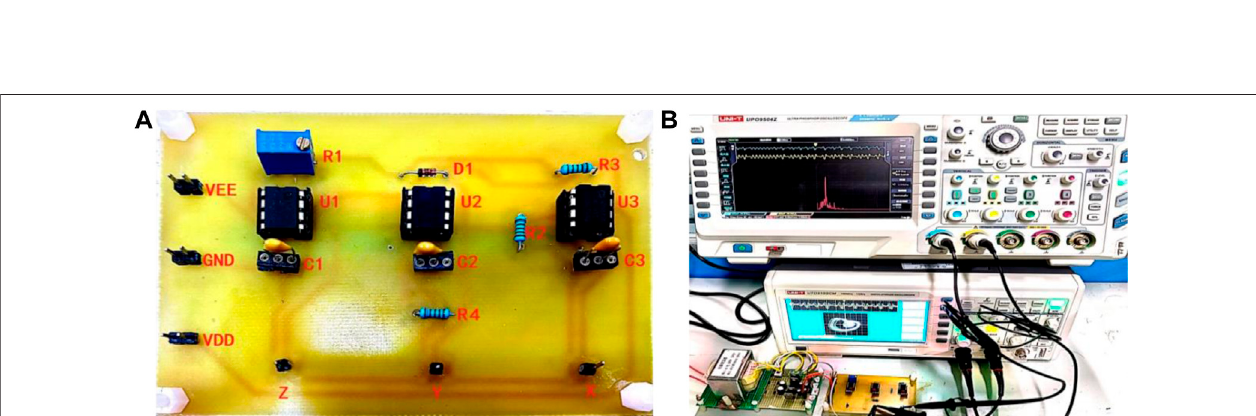
FIGURE 5 | Offset boosting behaviors of the system (13) for the constant k . (A) 3D phase diagram of the boosted attractors for k = 2 (blue), k = 0 (red), k = − 2 (yellow). (B) x-y planephasediagramsoftheboostedattractorsfor k =2(blue), k =0(red), k = − 2(yellow). (C) Theaverageofeachvariable x , y ,and z . (D) theamplitudeof variables x , y , and z